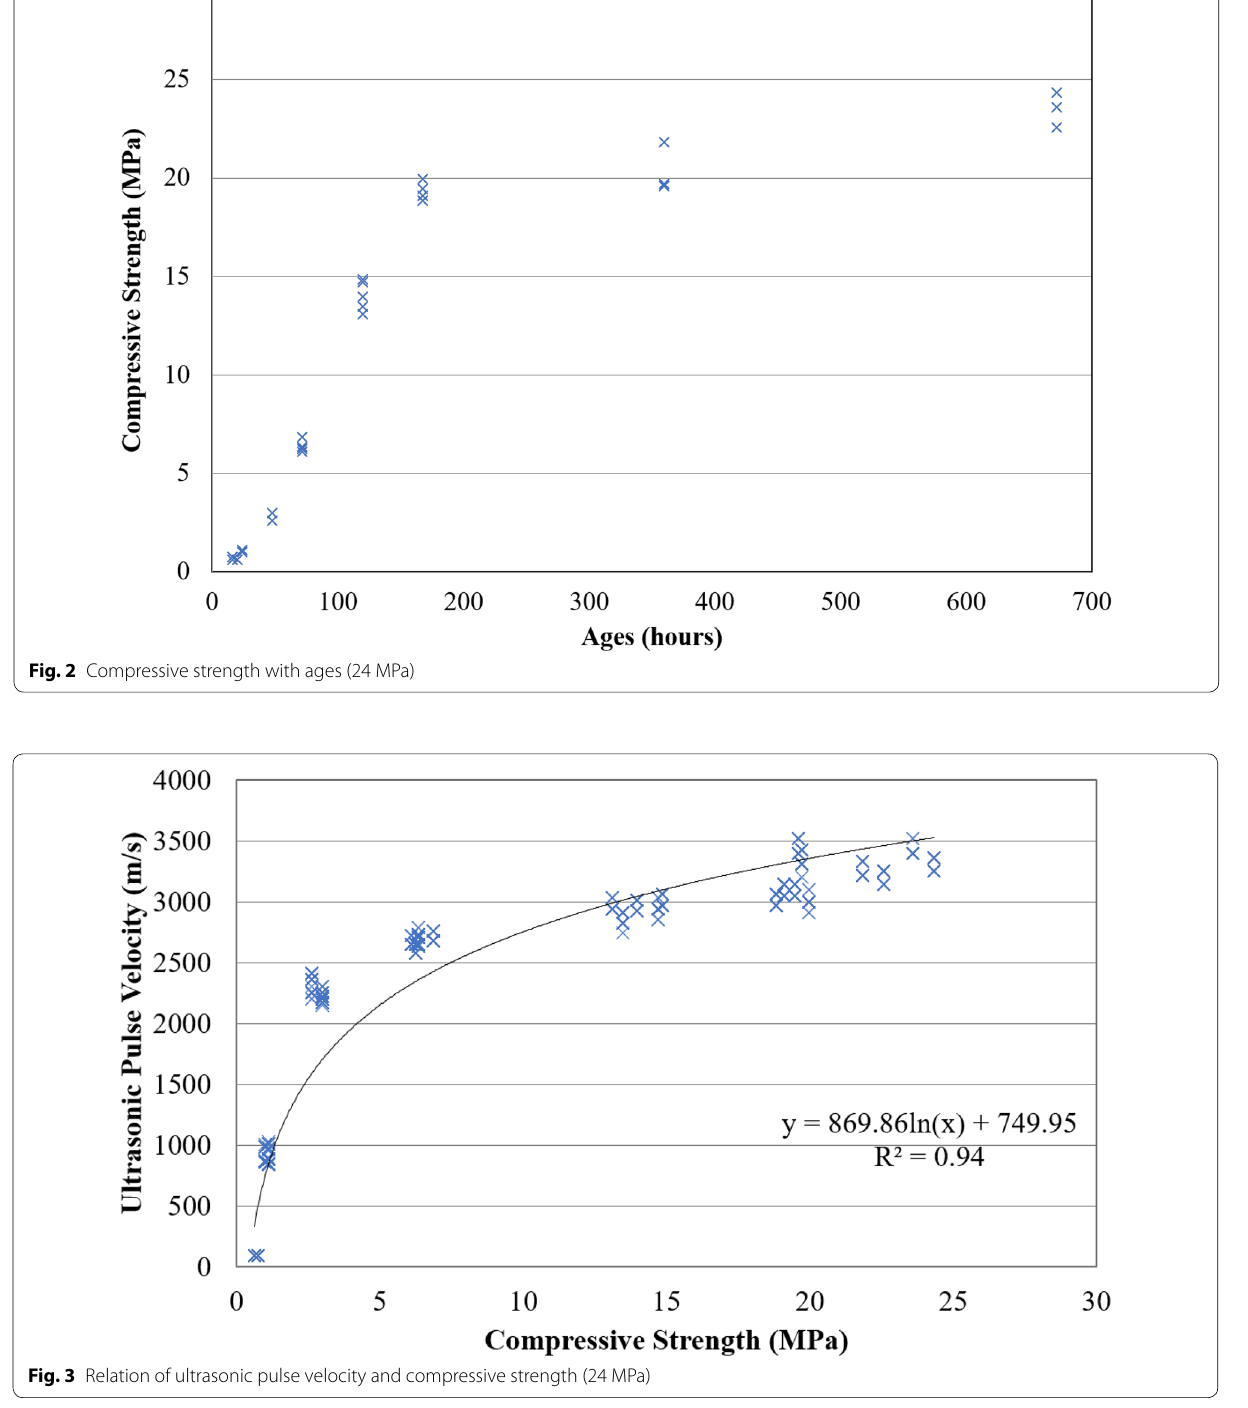
Fig. 3 Relation of ultrasonic pulse velocity and compressive strength (24